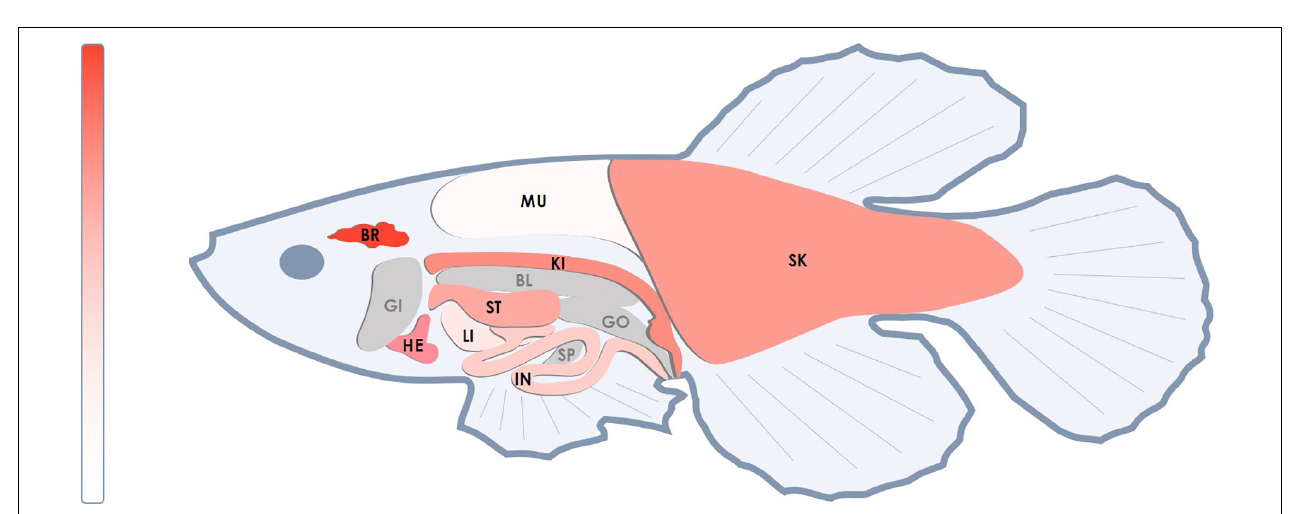
FIGURE 4 | Relative mRNA levels of the neto2b gene in different tissues of N. furzeri . The highest mRNA level of neto2b was detected in the brain tissue and was taken as 1. The expression of neto2b in other studied tissues was measured relatively this value. Darker red indicates higher expression. Gray color indicates tissues where the gene expression has not been measured. BR, brain; HE, heart; ST, stomach; SK, skin; IN, intestines; LI, liver; KI, head kidney; MU, muscles; SP, spleen; BL, bladder; GI, gills; GO,